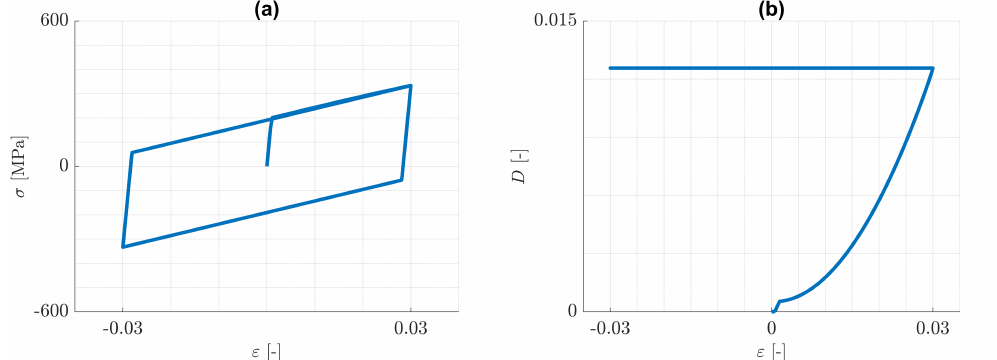
Figure 3. Cyclic, uniaxial tension/compression loading: pure kinematic hardening. Predicted ( a ) ( ε , σ ) -distribution and ( b ) ( ε , D )